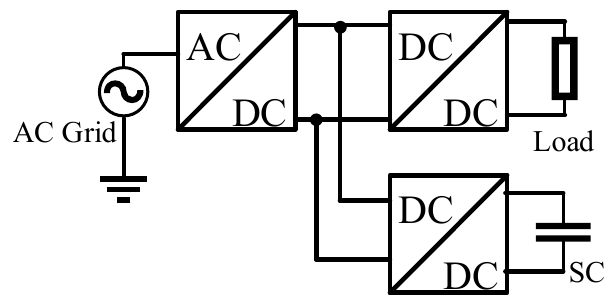
Figure 18. Schematic diagram of the additional supercapacitor structure.